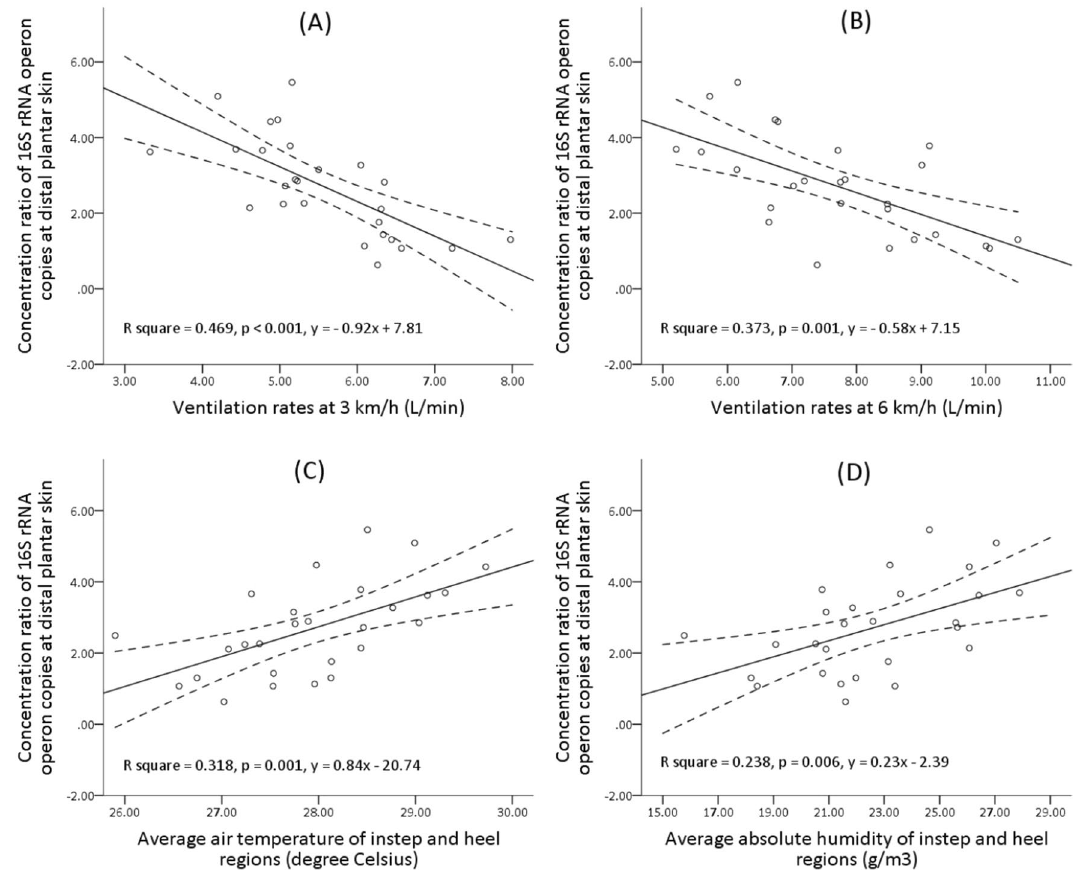
Figure 8. Linear regression results (scatters and fit lines) between footwear microclimate [ventilation rate at 3 km/h (A) , ventilation rate at 6 km/h (B) , average in-shoe temperature of instep and heel regions (C) , and average absolute humidity of instep and heel regions (D) ] and bacterial growth rate at the distal plantar skin of the right